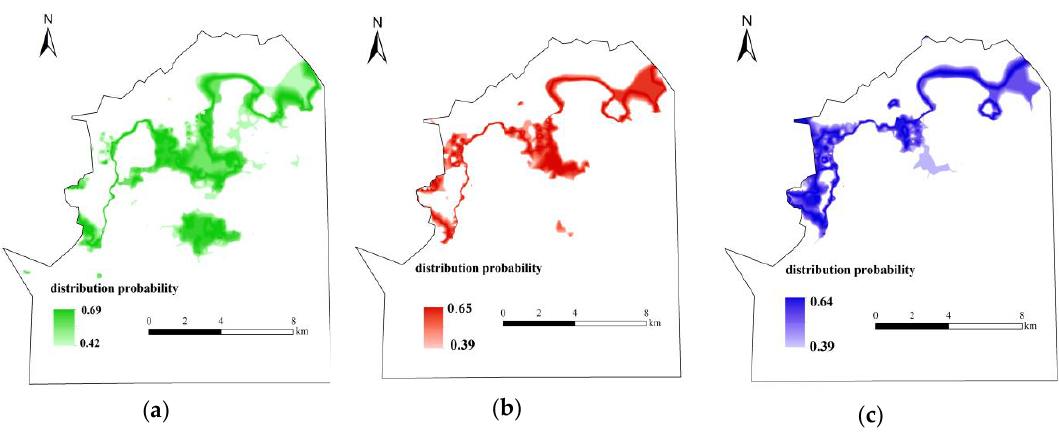
Figure 7. The distribution map of the most suitable habitat for wetland vegetation ( a ): Calamagrostis angustifolia ; ( b ): Carex lasiocarpa ; ( c ): Carex pseudocuraica .